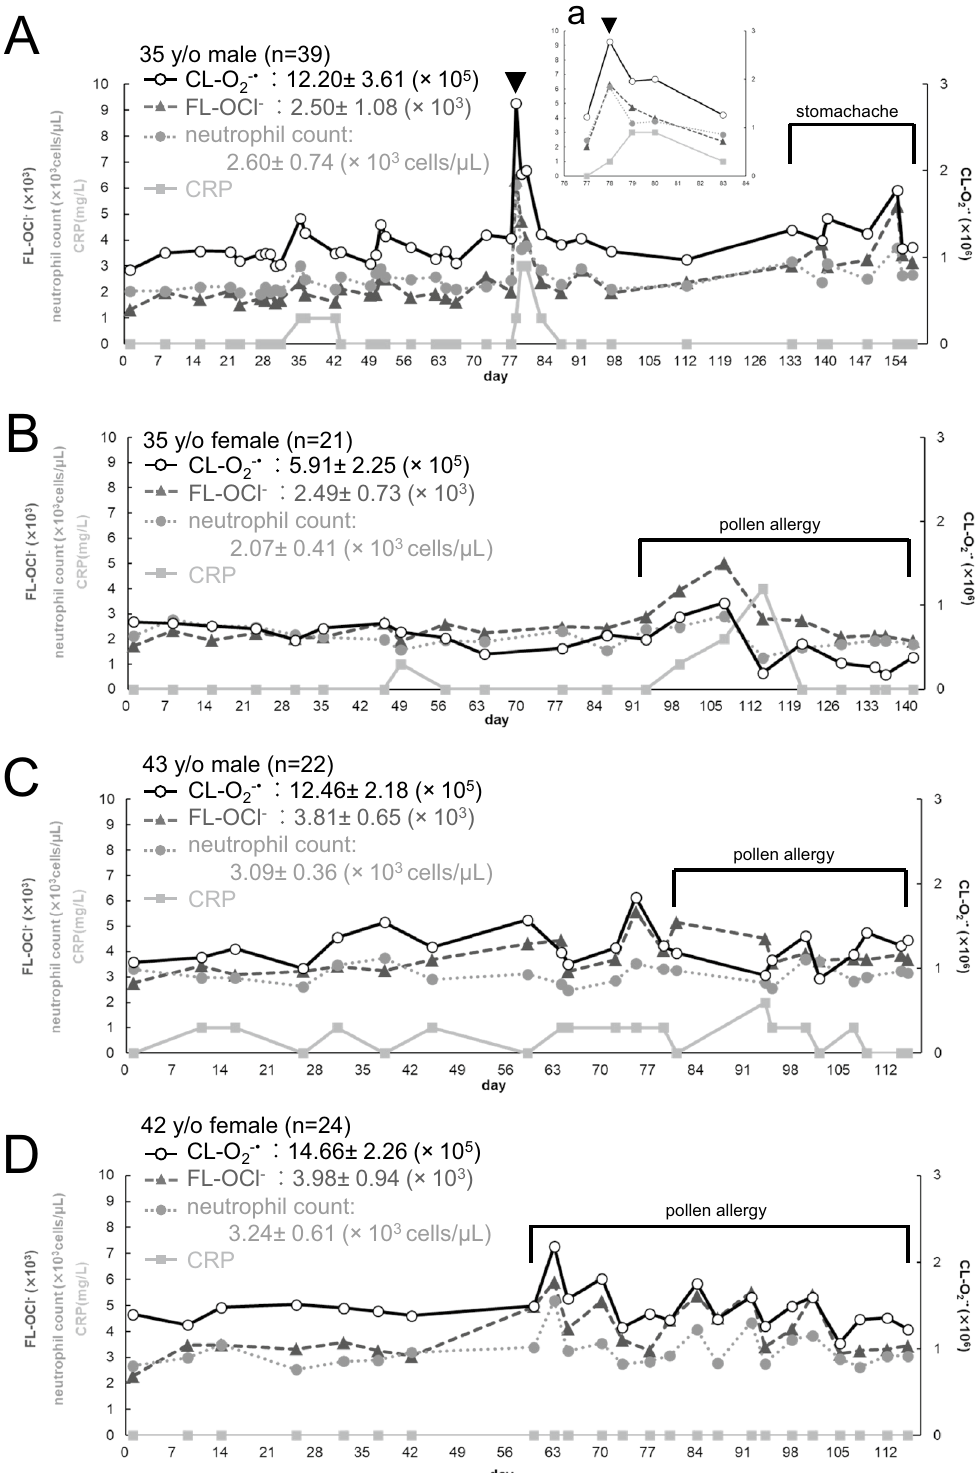
Figure 4. Day-to-day variations of CL-O 2−· and FL-OCl − in six healthy subjects. Scatter plots showing the day- to-day fluctuations of CL-O 2−· ( ○ solid line), FL-OCl − ( ▲ dashed line), neutrophil counts ( CRP ( ■ solid line) in six healthy volunteers. The left vertical axes indicate FL-OCl − , neutrophil counts and CRP; the right vertical axes, CL-O 2−· . The horizontal axes indicate dates (weekly intervals) during the measurements. The mean values of CL-O 2−· , FL-OCl − and neutrophil counts, and variation ranges of them were indicated at the upper left in each figure. ( A ) 35 y/o male (n = 39), ( a ) partially expanded view (Day 76–84). ( B ) 35 y/o female (n = 21). ( C ) 43 y/o male (n = 22). ( D ) 42 y/o female (n = 24). ( E ) 52 y/o male (n = 25). ( F ) 54 y/o female (n =